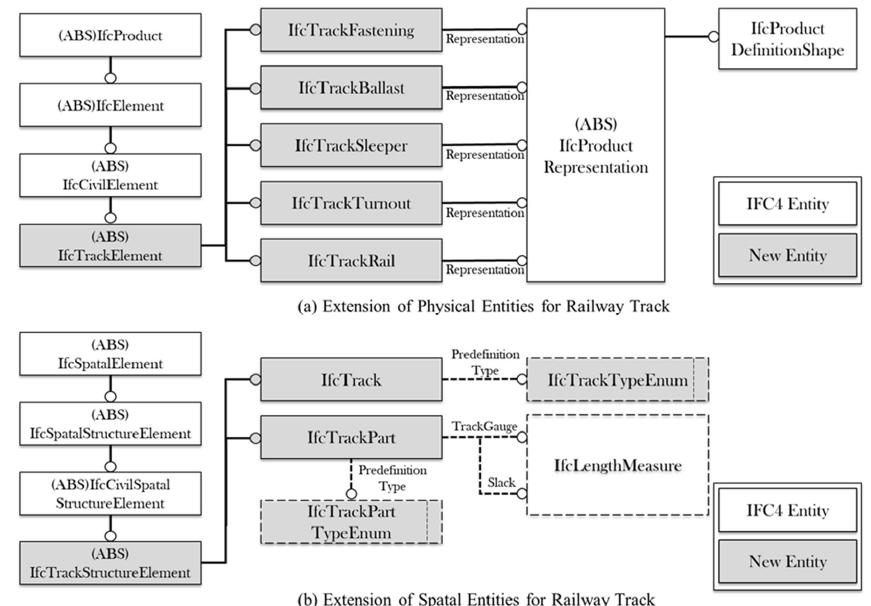
Figure 4. Extended IFC entities for railway tracks: ( a ) Extension of physical entities; ( b ) extension of spatial entities.